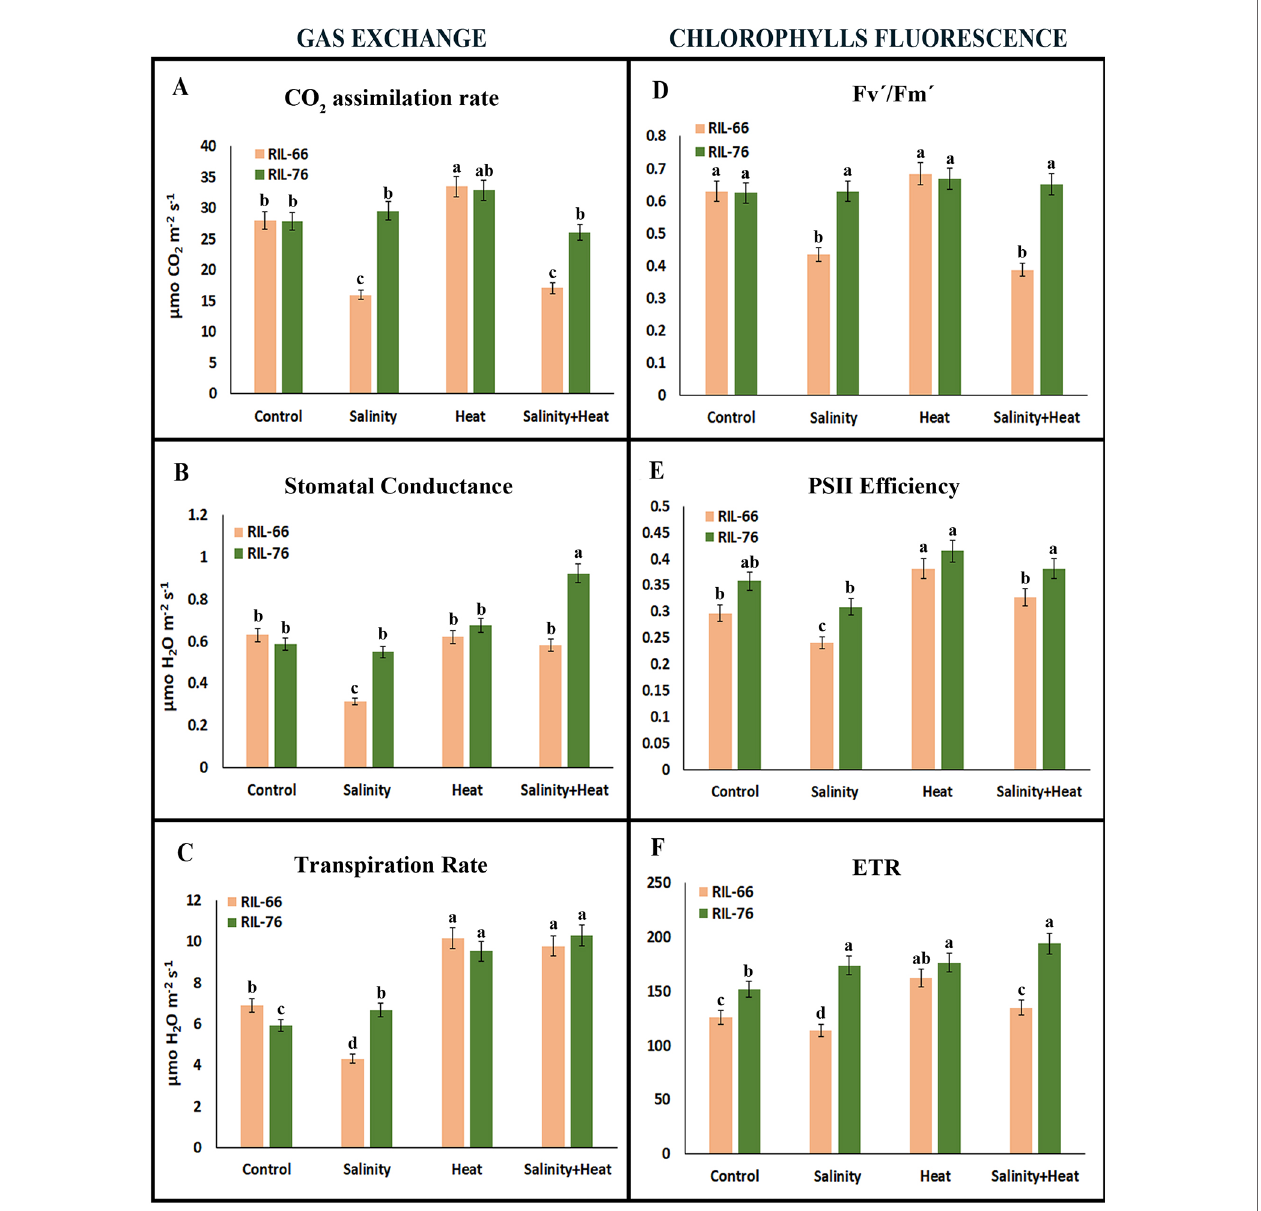
FIGURE 3 | Gas exchange parameters (A – C) and chlorophyll fl uorescence parameters (D – F) in tomato recombinant inbred line (RIL)-66 and RIL-76 under control, salinity, heat stress, and the combination of salinity and heat. Each fi gure is representative of three different measurements during the experiment. Bars are mean values ± SE (n = 6), and bars with different letters are signi fi cantly different at p < 0.05 according to Tukey's test. (n =